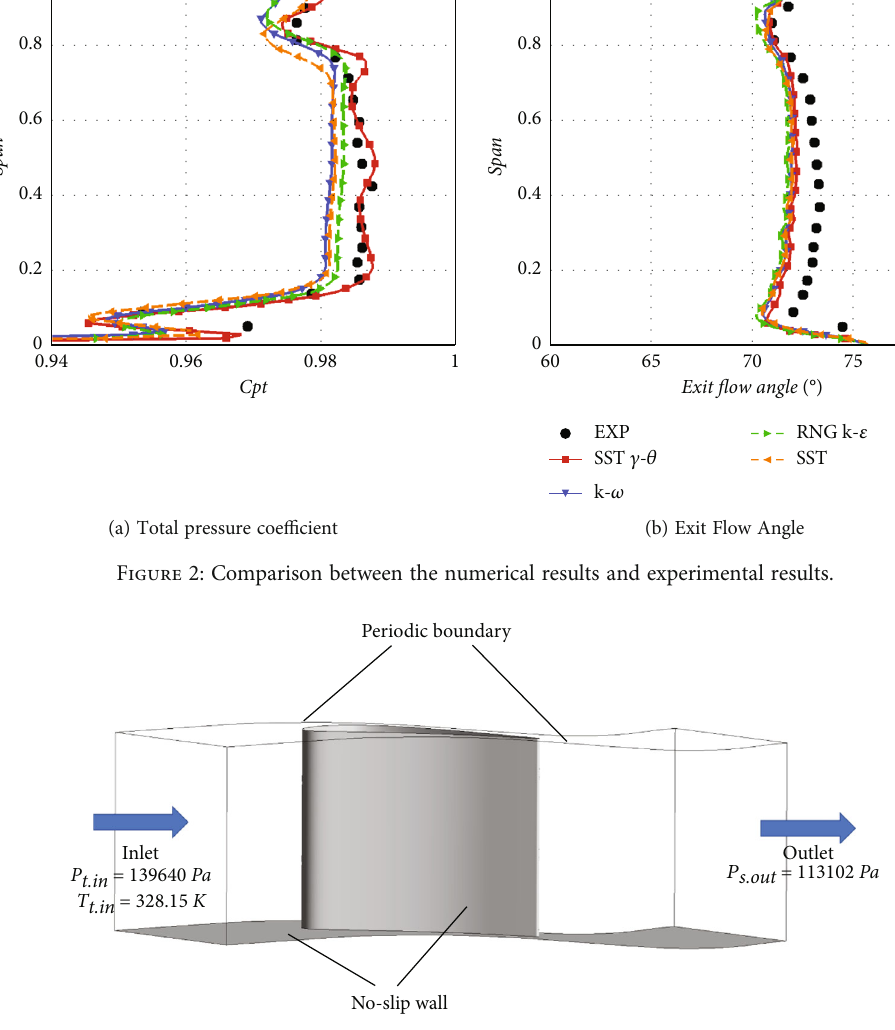
Figure 3: Computational domain and boundary conditions.